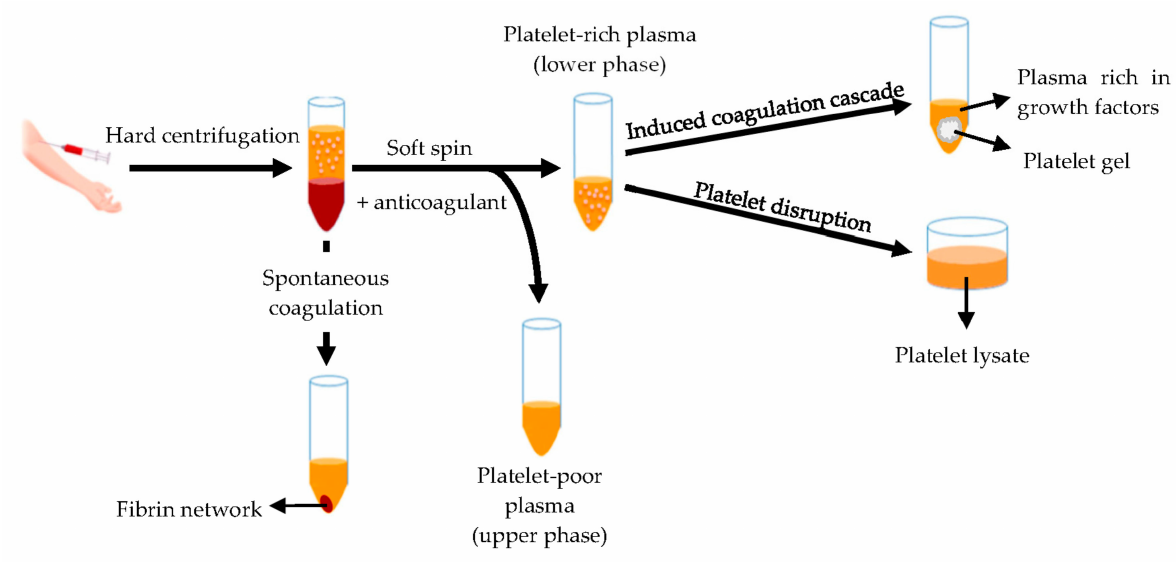
Figure 8. Schematic representation of the blood derivatives production by means of double centrifugation technique. Modified from [141]. CC BY